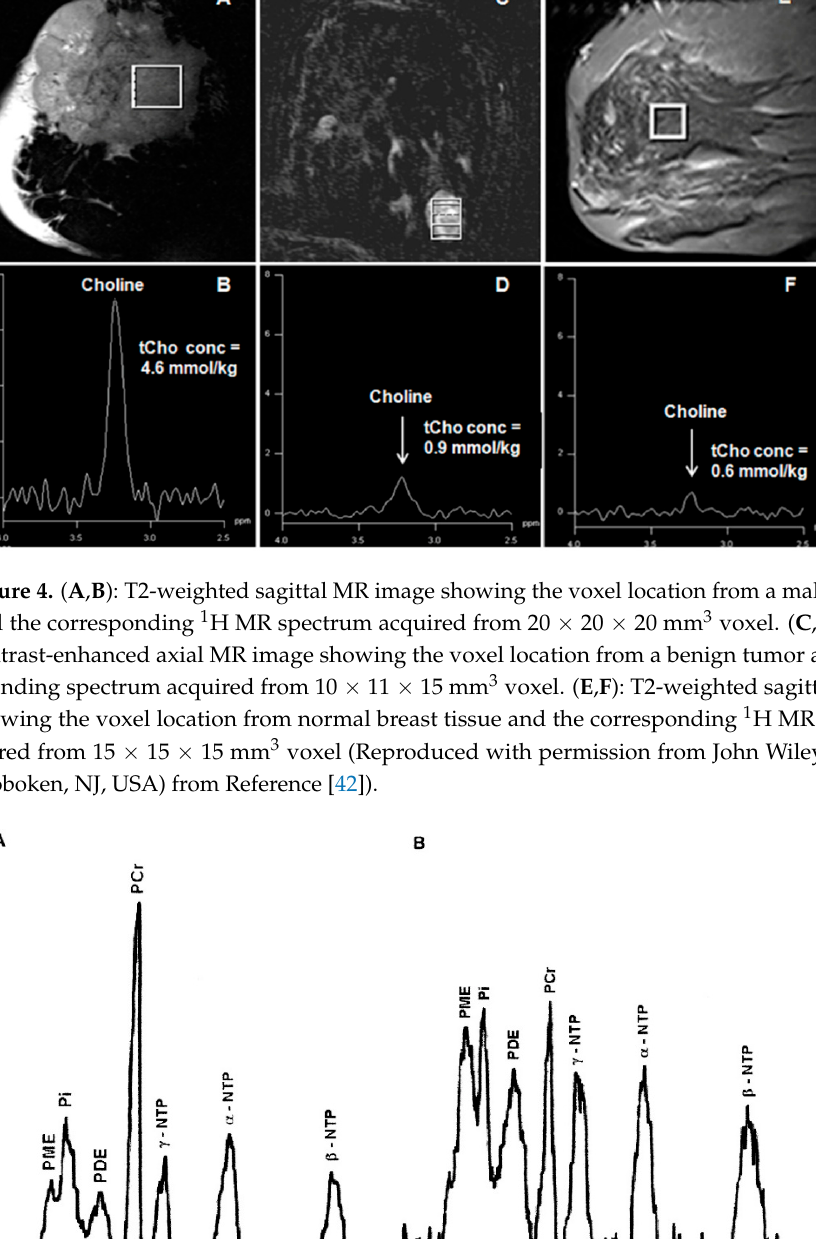
Figure 5. ( A ) 31 P MR spectrum from the normal breast tissue of a volunteer. NTP- nucleotide triphosphate; PDE-phospho-diesters; PME-phospho-monoesters; PCr-phosphocreatine; Pi-inorganic phosphate. ( B ) 31 P MR spectrum of a patient suffering from IDC. (Reproduced with permission from Springer from Reference [111])